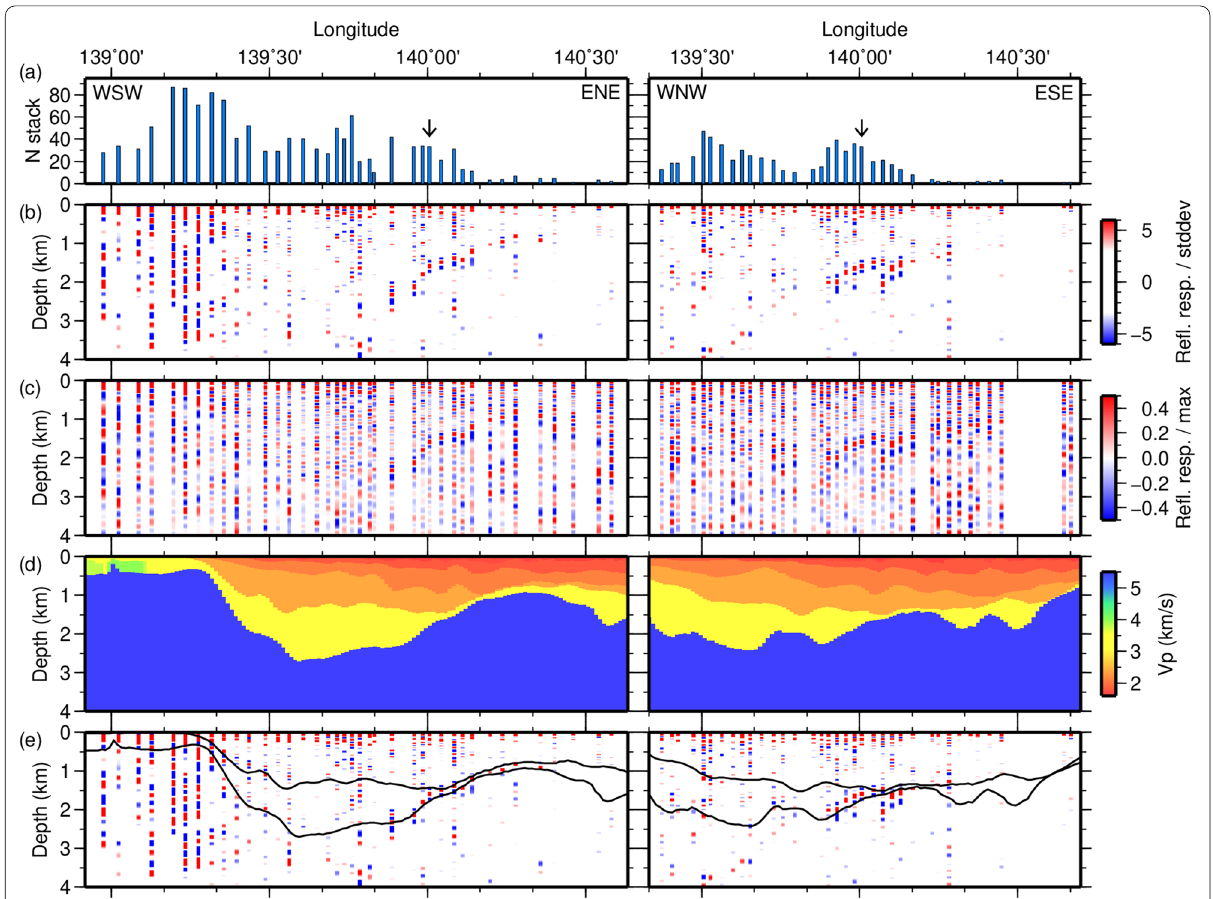
Fig. 4 Reflection responses along the ENE–WSW and ESE–WNW transects that are shown in Fig. 1. a Number of stacks. Arrows indicate Station E.STHM. b Reflection responses estimated using our method. The color is based on the ratios of the averages to standard deviations of weighted stacks ( a ave (τ)/σ a (τ) ). White is used for amplitudes of less than three. c Reflection responses estimated using the conventional procedure, where stacking was performed without weights. The color is based on the ratio of the amplitudes to the maximum amplitude for τ ≥ 0.2 s at each station. d J-SHIS P-wave velocity model (NIED, 2019b) used to convert lag time to depth in b and c . Gradations of red to orange indicate layers with low velocity ( ≤ 2400 m/s). Yellow indicates an intermediate-velocity (3200 m/s) layer. Blue indicates a high-velocity (5500 m/s) layer. e Boundaries between low-, intermediate- and high-velocity layers from d superposed on